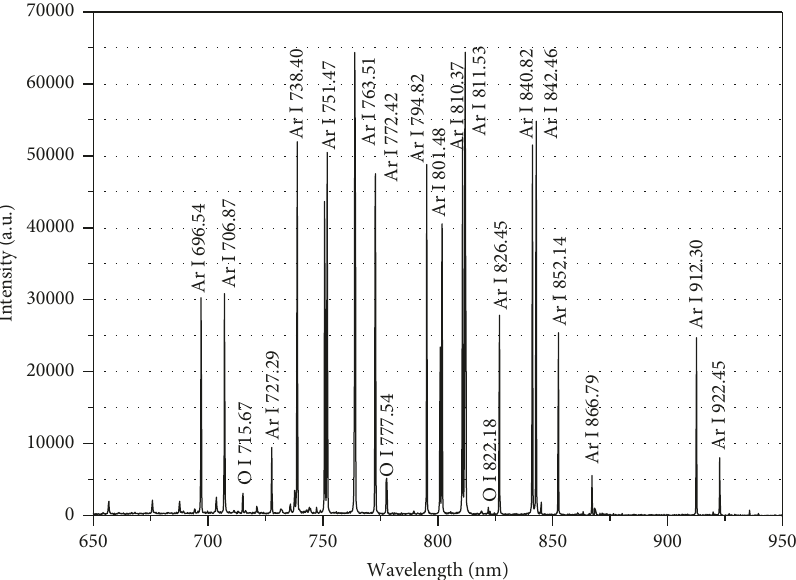
Figure 3: Emission spectra of Ar plasma jet in the wavelength range of 650 ∼ 950 nm.